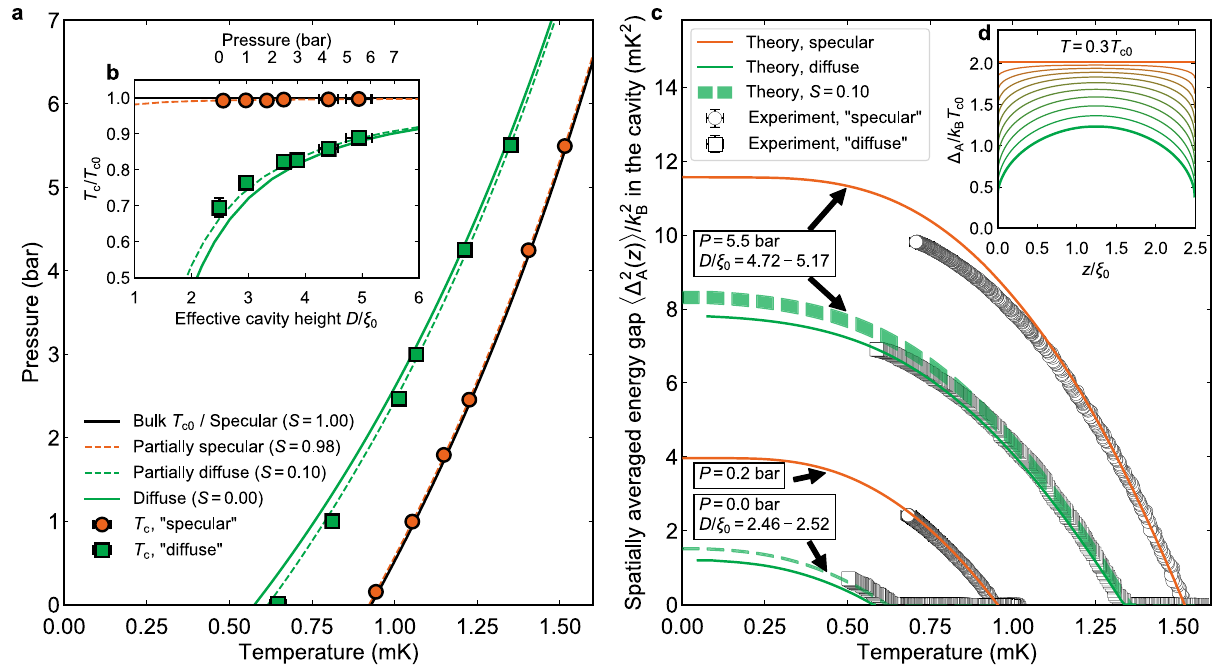
Fig. 2 Suppression of super fl uid transition temperature and super fl uid gap for different surface scattering conditions. a Measured pressure dependence of T c for close to diffuse (squares) and close to specular (circles) boundary conditions. Full lines show predicted T c for diffuse (green) and fully specular (black) boundaries, dashed lines are best fi ts yielding S = 0.1 and S = 0.98. b Suppression of T c relative to bulk super fl uid transition temperature T ‘ diffuse ’ boundary steeply increases with con fi nement. Suppression of T ‘ specular ’ boundary is essentially eliminated. The uncertainties in c0 for c for temperature determination and the modelled distortion of cavity height by pressure are used to de fi ne the vertical and horizontal error bars, respectively ( ‘ Methods ’ ). c Spatial average of energy gap Δ A ( z ), where z is the vertical position in the cavity, inferred from measured frequency shift (Supplementary Note 1), for ‘ diffuse ’ (squares) and ‘ specular ’ (circles) boundary conditions. All theoretical curves include strong-coupling corrections valid near T c . The ‘ diffuse ’ experiments agree best with theory for S = 0.1 (dashed lines, see also Supplementary Fig. 9). The emergent discrepancy between theory and experiment at lower temperatures at 5.5 bar, for both scattering conditions, is in agreement with the expected temperature dependence of strong-coupling corrections to the gap (Supplementary Note 4). The width of the theoretical curves for S = 0.1 accounts for errors associated with the weak pressure dependence and uncertainty of cavity height ( ‘ Methods ’ ). The theoretical curves for diffuse boundary condition (solid green lines) correspond to the mean value of D / ξ 0 at given pressure, and the theoretical curves for specular boundary condition (solid orange lines) correspond to the bulk energy gaps of 3 He- A. d The calculated gap pro fi le at zero pressure for specularities between 0 and 1 in intervals of